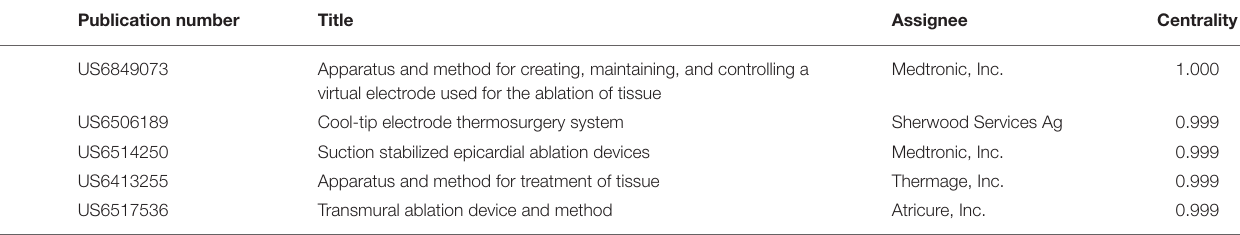
TABLE 10 | Top five central patents for the microwave and radiofrequency energy-based therapeutic technological domain with their assignees and centrality values.